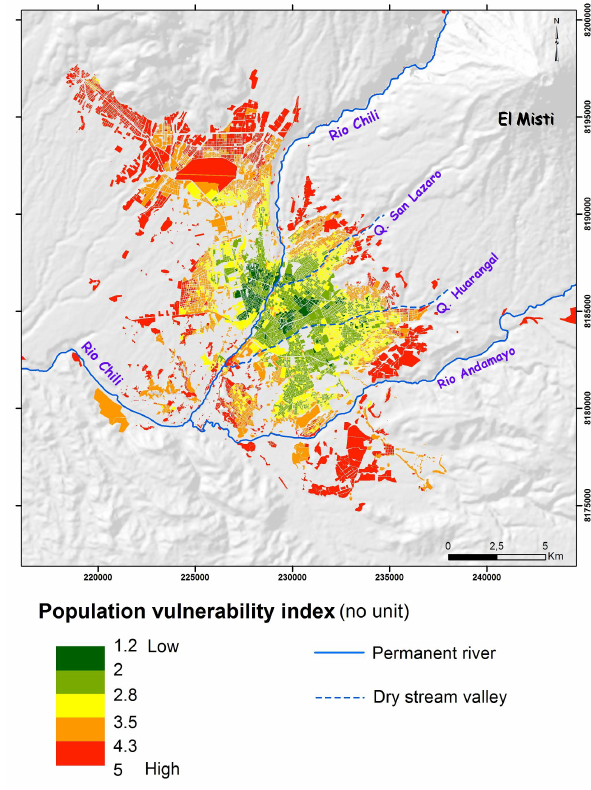
Fig. 11. Map showing the combined “isolation” of the population in Arequipa. The overall isolation index (II) comprises five classes (see Table 6a). The map takes into account road conditions (Ta- ble 6b). The scale of original data (city block) results in a high level of precision.